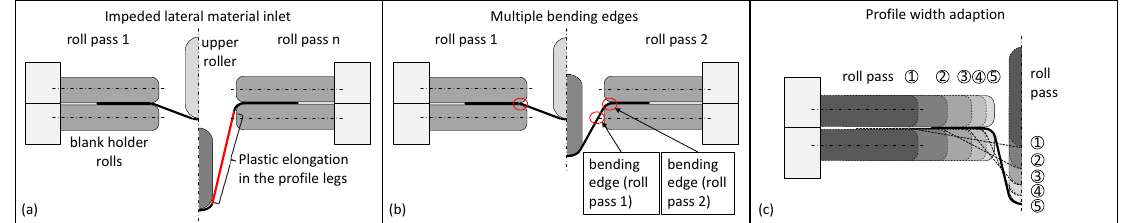
Figure 8. Blank holder roll set adaption: ( a ) risk of sheet stretching without adaption, ( b ) risk of multiple bending without adaption, and ( c ) principle of blank holder roll set adaption.